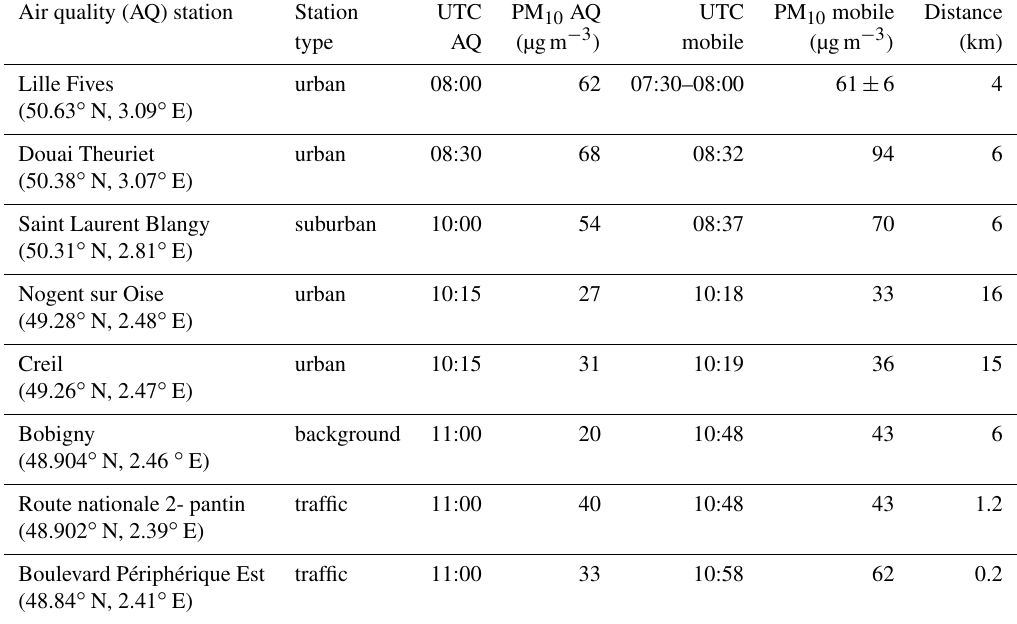
Table 1. Comparison of measured PM 10 from air quality stations closest to the investigated route and the corresponding mobile measure-